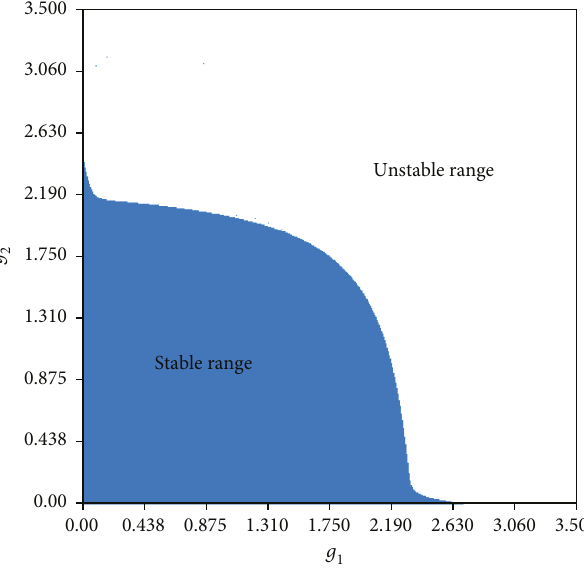
Figure 2: The 2D stable region of g